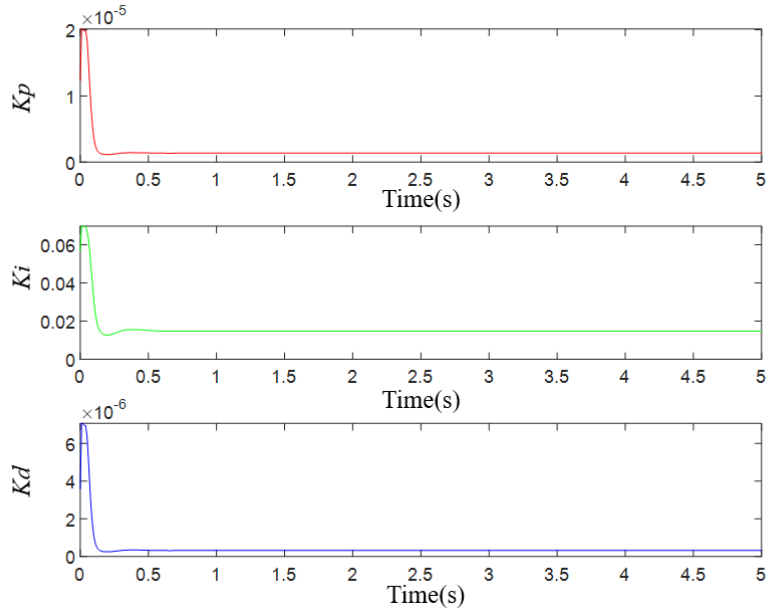
Figure 12. The adaptive curve of step response parameter of the PSO-BP-PID controller.